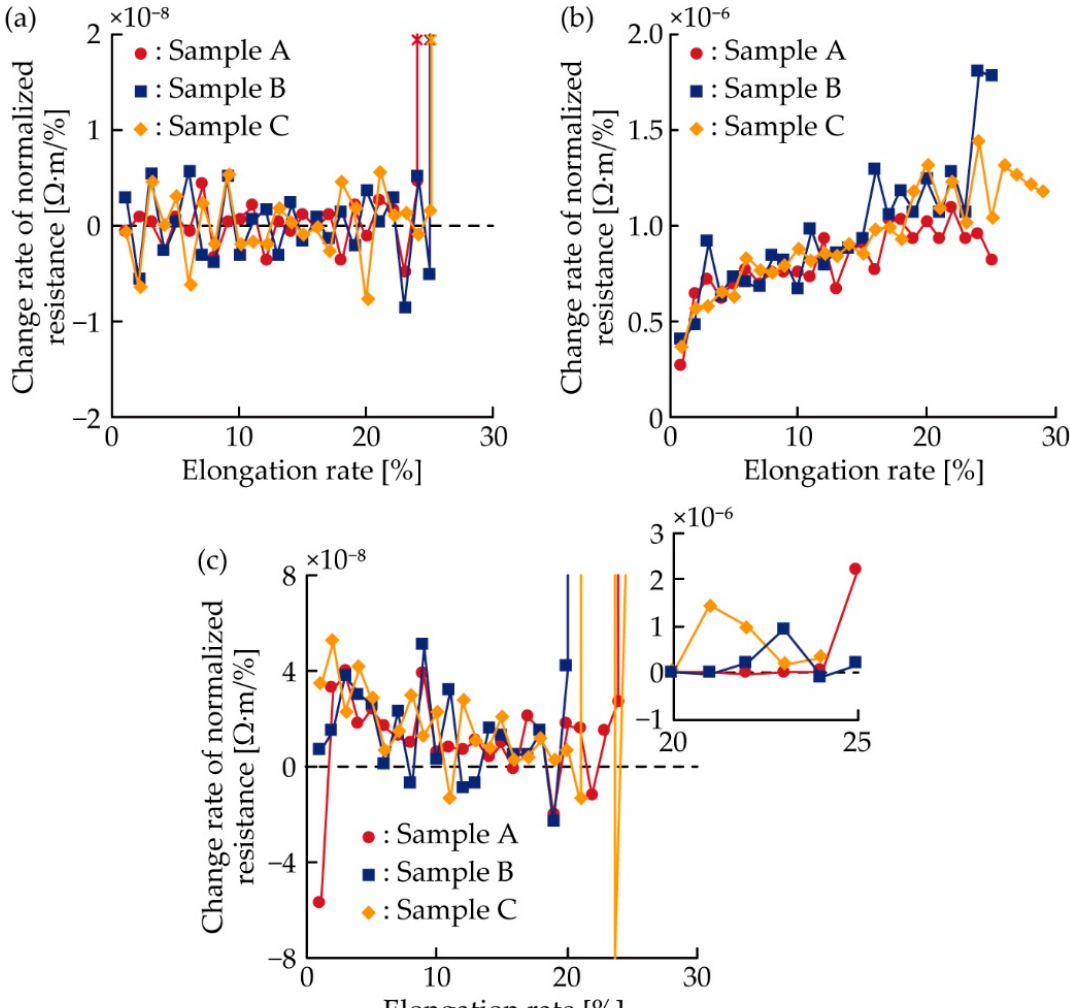
Figure 6. Change rate of the normalized resistance against the elongation rate of 1% in Figure 5a–c; ( a ) meandering copper; ( b ) silver ink; and ( c ) double-layered